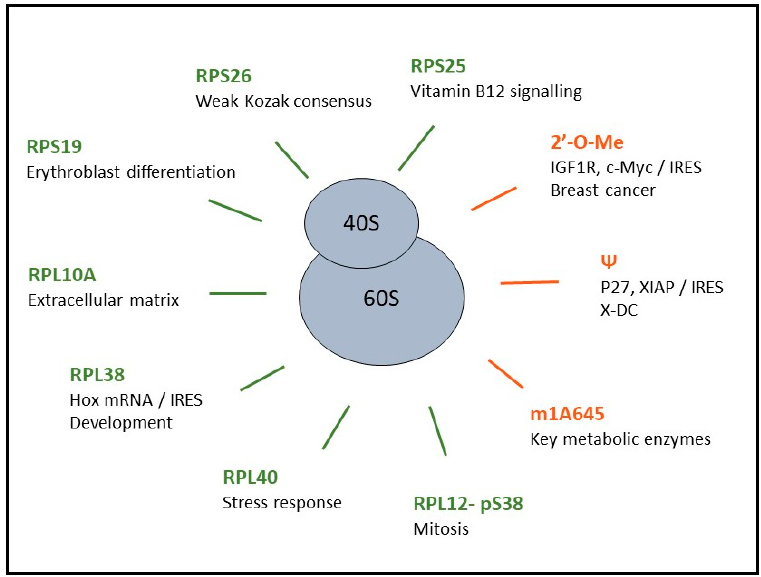
Figure 3. Heterogeneity in ribosome composition impacts translation of various mRNAs subsets. Examples of alteration in the ribosome composition (RP defect or post-translational modification, or rRNA modification) and associated features of preferentially translated mRNAs. Hallmarks colors are as follows: ribosomal protein (RP) defects (green) and rRNA modifications (orange).